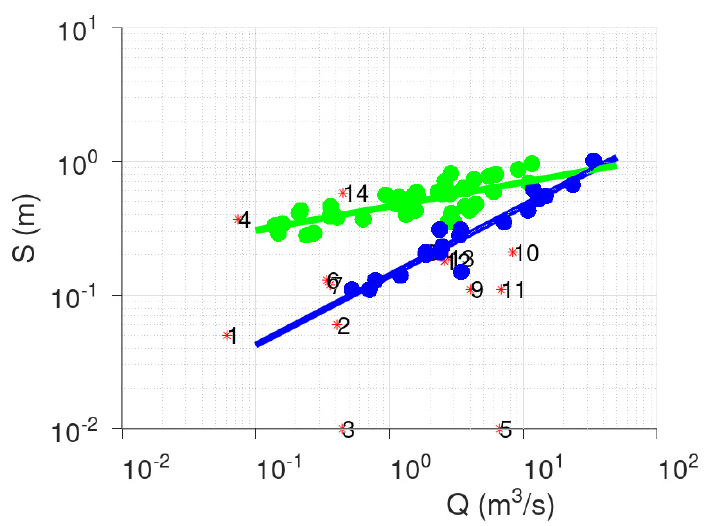
Figure 5. Sakoulevas case study—scatter plot of stage vs. discharge. With different colours, the partition of DBSCAN. Period 1 (02/1964–04/1966) with blue dots, period 2 (05/1966–01/1972) with green dots, outliers with red stars.